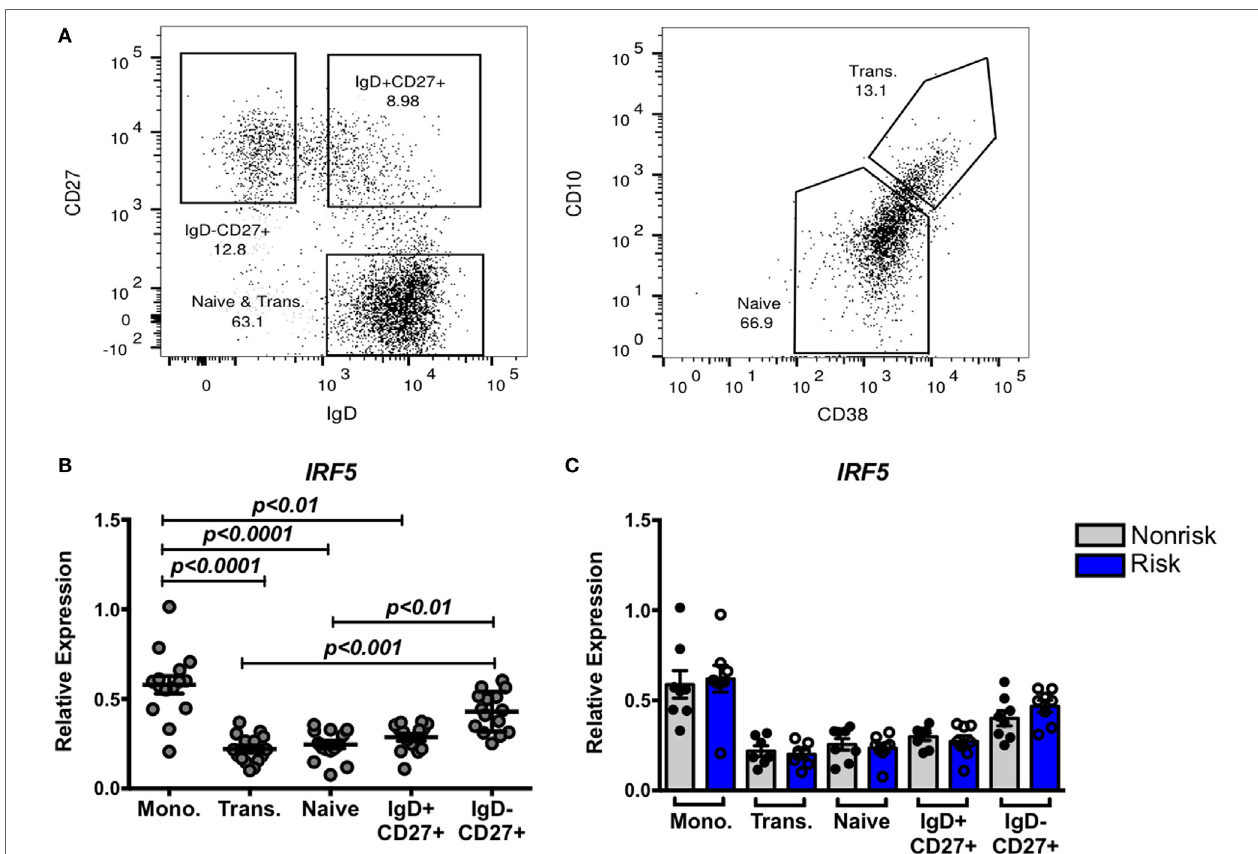
FigUre 2 | Interferon regulatory factor 5 (IRF5) expression is higher in monocytes and IgD − memory B cell subsets independent of haplotype. Monocytes and four subsets of B cells were sorted after gating on CD14 + and CD19 + cells, respectively. (a) Gating strategy for IgD + CD27 + , IgD − CD27 + , CD27 − CD10 lo CD38 l0 (naive), and CD27 − CD10 hi CD38 hi (transitional) B cells. Sorted cells were subjected to qPCR for IRF5 (B,c) , and results are shown combined (B) and separated by haplotype (c) . p < 0.01 by Friedman test with Dunn’s multiple comparisons test (B) , p = ns by Mann–Whitney test for each B cell subset (c)